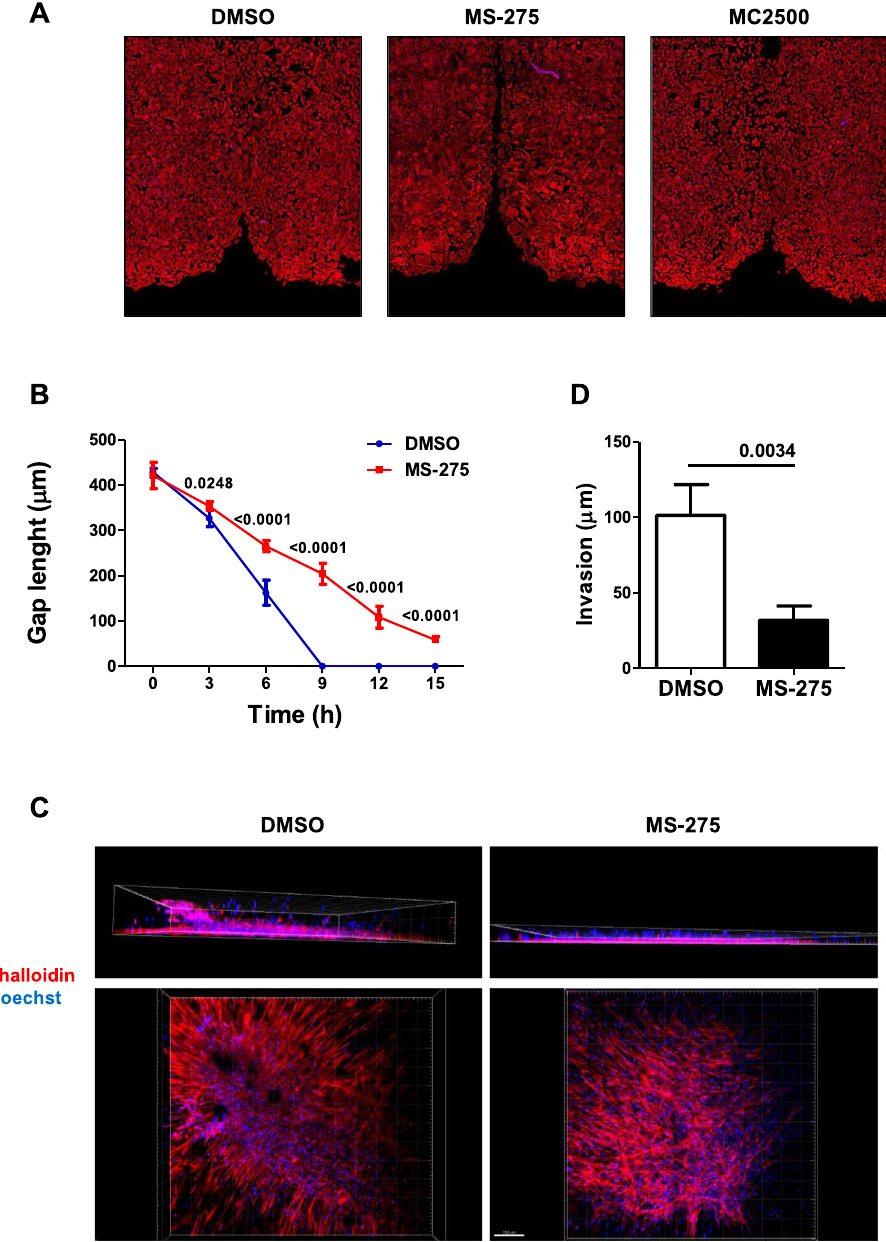
Figure 5. Treatment with MS-275 mediates inhibition of directed cellular motility as well as of three dimensional invasion. ( A ) Effect of treatment with MS-275 on wound closure. MCs from patients undergoing PD were allowed to reach 100% confluency in an Ibidi μ -Dish. MCs were pre-treated with DMSO, MS-275 (250 nM) or MC2500 (250 nM) for 48 h in culture medium supplemented with 10% FCS. Therefore, the insert was removed and after 18 h cells were fixed and stained with phalloidin (red) or Hoechst33342 (blue) to stain nuclei. Representative experiment is shown of three performed. ( B ) MCs were treated as above. After removal of the insert, the wound area was photographed every 30 min for 15 h by bright field microscopy. The width of the wound was measured and the wound closure rate was calculated. 9 different points from 3 different scratches were analyzed per condition. The result described is representative of 3 independent experiments. Values of MS-275-treated cells compared to DMSO-treated cells are reported. (C , D ) Effect of treatment with MS-275 on three-dimensional invasion by MCs from patients undergoing PD. ( C ) MCs were pretreated (24 h) with DMSO or MS-275 (250 nM) and then overlaid with a Matrigel matrix. Invasion was monitored over 48 h. Three- dimensional invasion was enhanced by adding 20% FCS to the well. Cells were fixed and stained with phalloidin (red), and Hoechst 33342 (cell nuclei; blue). Top: xz maximal projection; Bottom: xy acquisition at the top of the well. Scale bar: 100 μ m. Representative experiment is shown, of 3 experiments performed in duplicate. ( D ) Quantification of the experiment shown in ( C ). Cellular invasion was quantified through Huygens (SVI) and visualized through Imaris image analysis software. P < 0.05 was considered